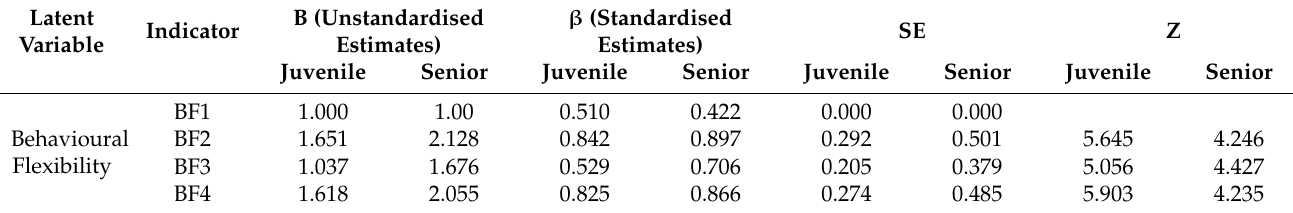
Table 2. Standardised and unstandardised regression coefficients for the oblique 6-factor solution (DEFS model). p -values for all latent variables are < 0.001 ***, with the following exceptions: